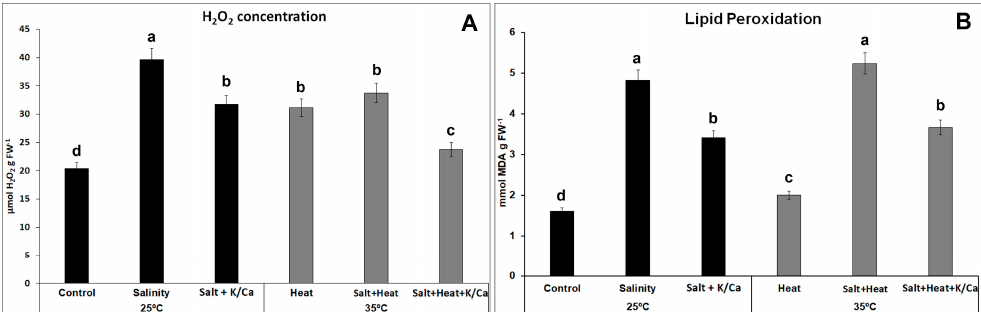
Figure 4. H 2 O 2 concentration ( A ) and Lipid peroxidation rate, measured as MDA concentration ( B ) in tomato leaves grown under control, salinity (60 mM NaCl) or salinity combined with a higher concentration of K + and Ca 2+ in the irrigation solution at optimal temperature (25 °C) or under heat stress (35 °C). Values represent means ± SE ( n = 6). Bars with different letters within eahc panel represent data with significant differences at p < 0.05 (Tuket HSD).